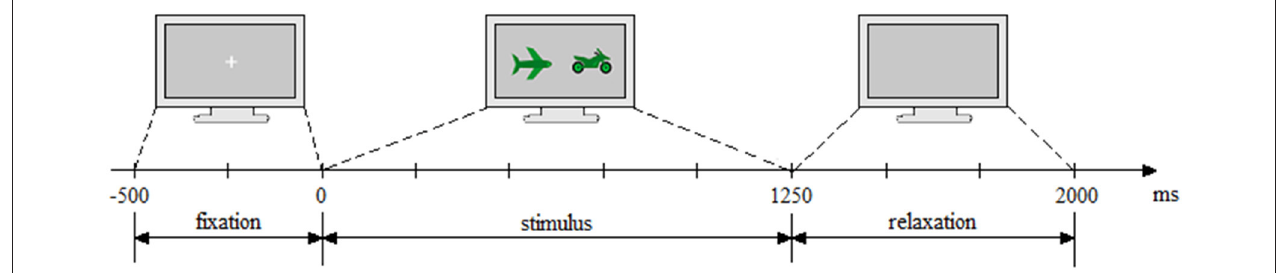
FIGURE 3 | Experiment timing. First, the fixation cross was displayed (500 ms), followed by the trial execution (1,250 ms) and ended with the relaxation period (750 ms, light gray blank screen).